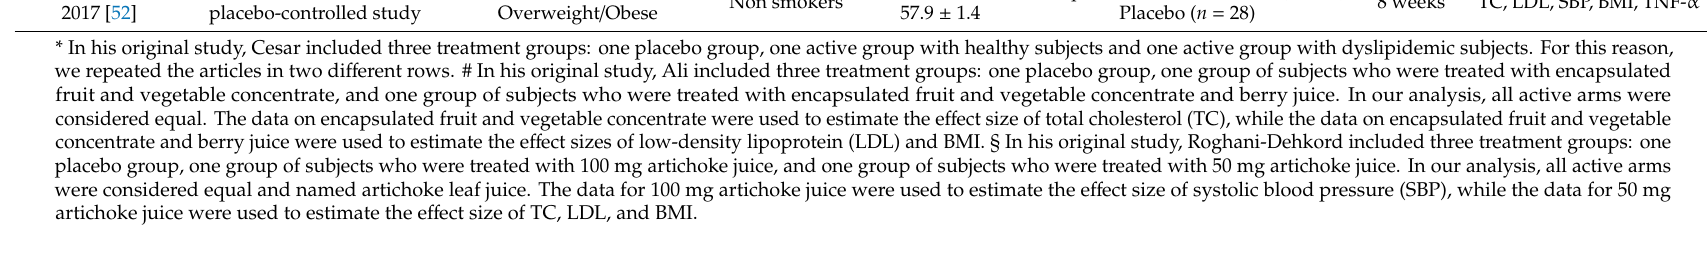
Table 4. Estimated e ff ect in terms of the absolute numbers of event reductions and their associated direct costs for di ff erent supplementation regimes in the general population, projected in 2025. The median and the 95% credibility interval are reported. Reported events are expressed in millions of events (95% C.I. lower bound; median; 95% C.I. upper bound), while direct costs are expressed in billions of dollars (95% C.I. lower bound; median; 95% C.I. upper